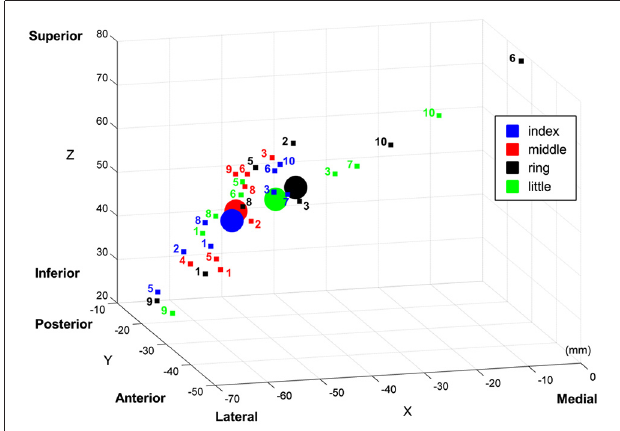
FIGURE 5 | “Center of mass” coordinates of the each finger representation in MNI space within primary somatosensory cortical area (S1) . The “center of mass” coordinates of individual participant are marked with small squares, and the averaged “center of mass” coordinates are marked with circles. Note that the text next to individual “center of mass” indicates its participant